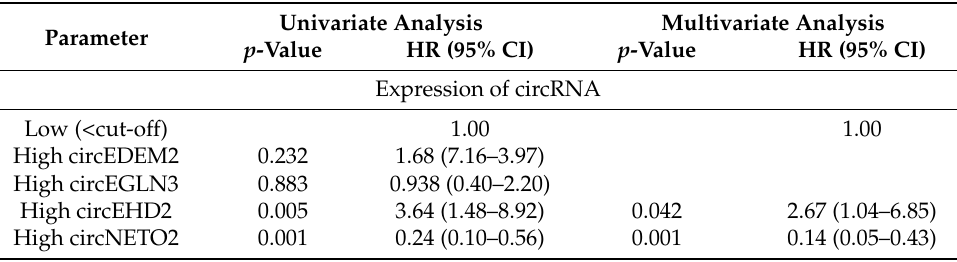
Table 3. Uni- and multivariate Cox regression analysis for cancer-specific